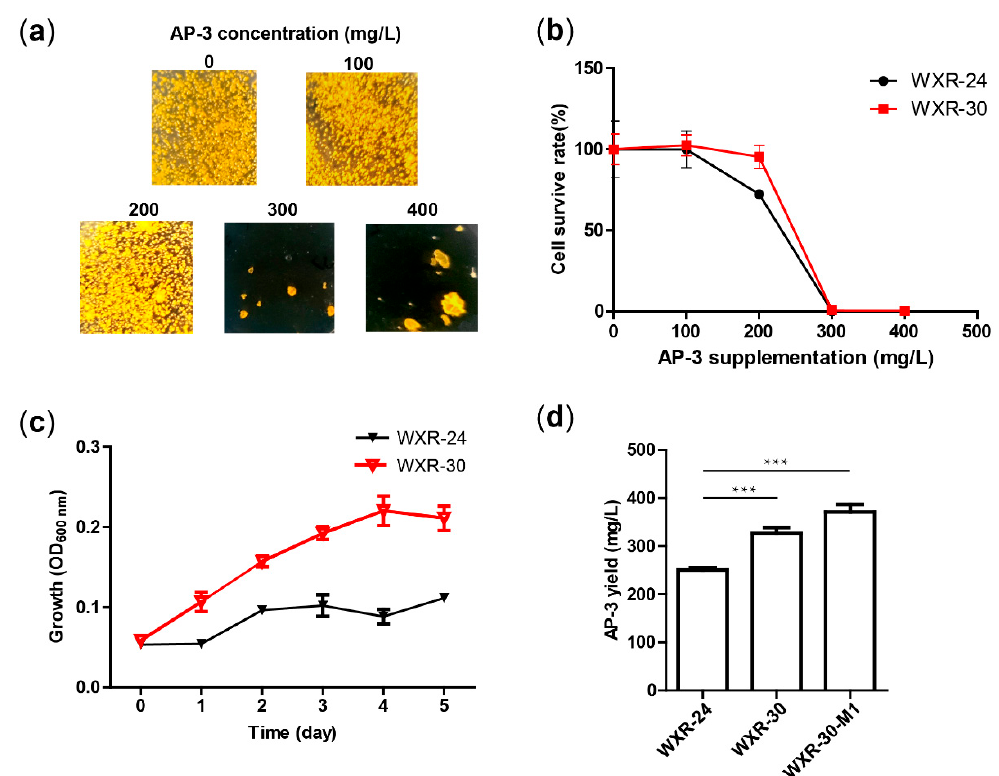
Figure 5. E ff ects of FtsZ overexpression on the resistance, growth and AP-3 yield of A. pretiosum WXR-30. ( a ) Growth of WXR-30 on YMG plates containing 0, 100, 200, 300 or 400 mg / L AP-3. The photos were taken on day 3 after inoculation. ( b ) Survive rate (%) of WXR-24 and WXR-30 on YMG plates containing 0, 100, 200, 300 or 400 mg / L AP-3. The survive rate on the plates supplemented without AP-3 was set as 100%, and the survive rates on other plates were accordingly calculated. Mean values of three independent experiments are shown with SD indicated by error bars. ( c ) Growth of A. pretiosum WXR-24 and WXR-30 in the fermentation broth containing 300 mg / L AP-3. Mean values of three independent experiments with SD are indicated by error bars. ( d ) AP-3 yields of WXR-24 and WXR-30 cultivated with 16 g / L yeast extract, and WXR-30 cultivated with 24 g / L yeast extract. Mean values of three independent experiments with SD are indicated by error bars. *** p < 0.001.